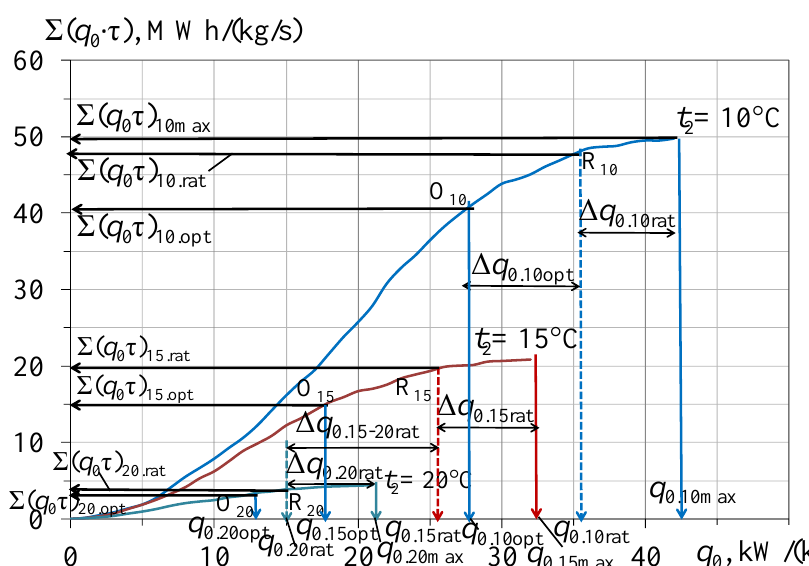
Figure 10. Specific annual refrigeration energy consumption ∑ ( q 0 · τ ); the rational q 0.10,15,20rat and optimal q 0.10,15,20opt values of design specific refrigeration capacity and their reductions ∆ q 0.10,15,20rat/opt due to rational and optimal designing and refrigeration energy exceedance recuperation while conditioning air to t a 2 = 10, 15 and 20 ◦ C: ∆ q 0.10,15,20rat = q 0.10,15,20max − q 0.10,15,20rat ; ∆ q 0.10opt = q 0.10rat − q 0.10opt ; ∆ q 0.15-20rat = q 0.15rat − q 0.20rat .